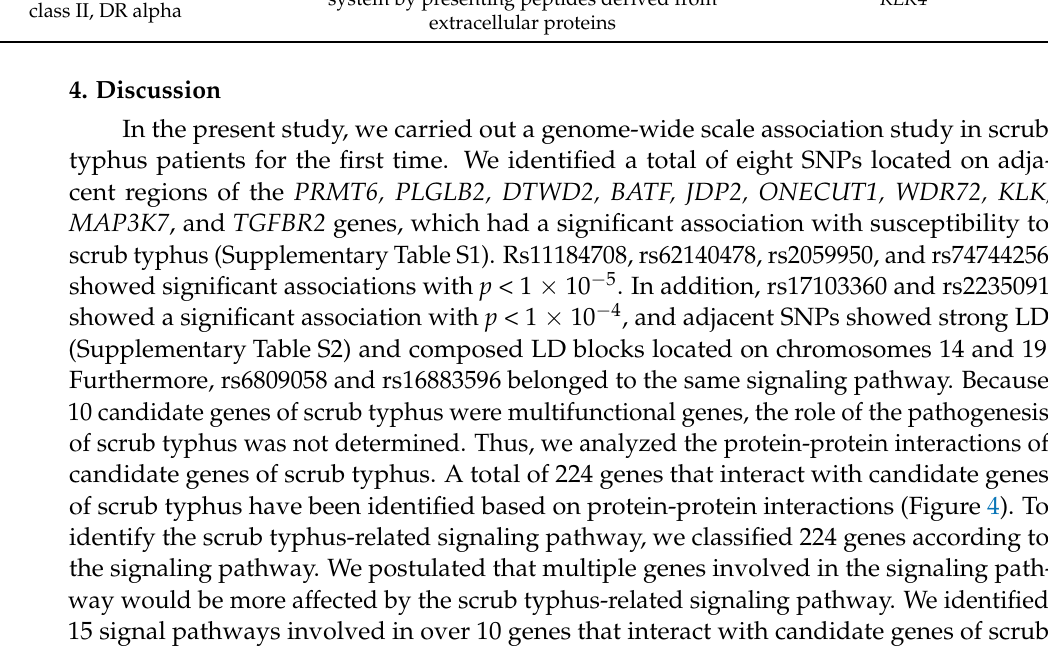
Table 3. Immune-related genes that interact with candidate genes of scrub typhus based on protein-protein interaction. Gene